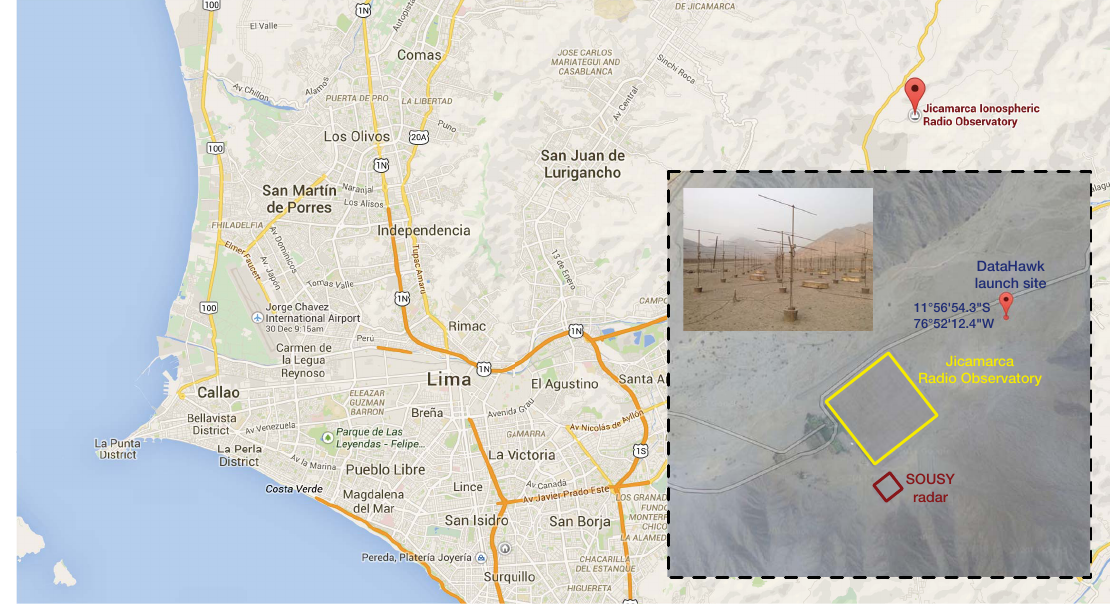
Figure 1. The Jicamarca Radio Observatory (JRO) is the experimental site for the observational campaign. JRO is located approximately 25km from the city of Lima. The DataHawk launch site is on the JRO property 400m from the main antenna (marked in yellow). The SOUSY radar is located next to the main antenna (marked in red). A picture of the SOUSY antenna elements is presented in the top left corner of the dash rectangle.